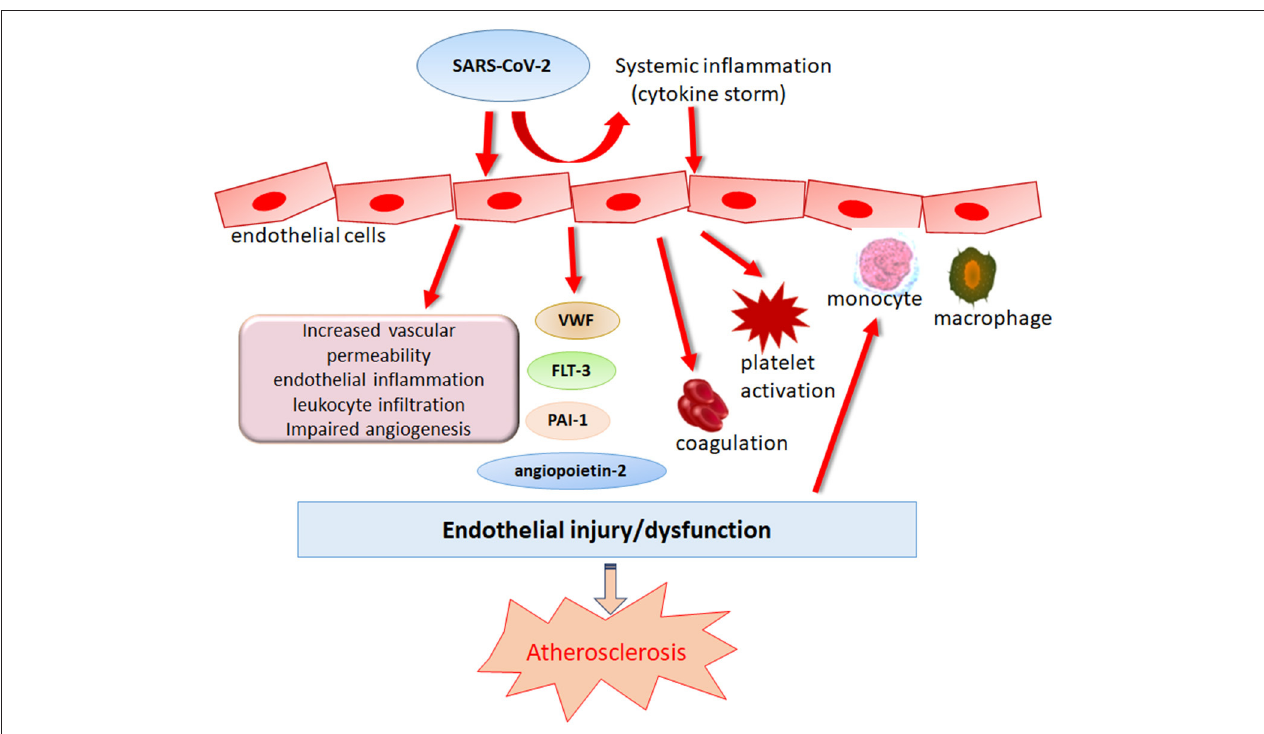
FIGURE 1 | Role of SARS-CoV-2 in endothelial dysregulation. Endothelial dysfunction is an initial step in the development of atherosclerosis that precedes clinical symptoms. SARS-CoV-2 can induce endothelial damage directly or indirectly by eliciting immune dysregulation which causes cytokine storm, leading to the deteriorations of endothelial